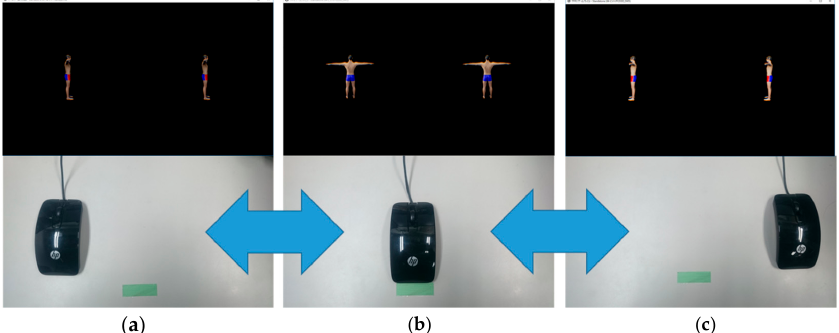
Figure 3. Mouse-associated virtual stereo rearview (MAR): In the case where the mouse is dragged toward the right, the avatar displayed in HMD is rotated in the counter clockwise (CCW) direction around the avatar trunk axis (e.g., from ( b ) to ( c ) in Figure 3). In the other case where the mouse is dragged toward the left, the avatar displayed in HMD is rotated in the clockwise (CW) direction around the avatar trunk axis (e.g., from ( b ) to ( a ) in Figure 3). As for the poses presented in the HMD, a total of 18 poses were introduced from “yoga” positions. Some of them were slightly altered to generate more difficult ones. They were classified into three categories, based on twisting and crossing motions.